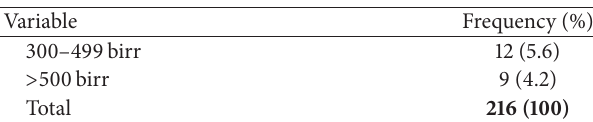
Table 1: Characteristics of the diabetic patients in Dessie Referral Hospital, 2013.